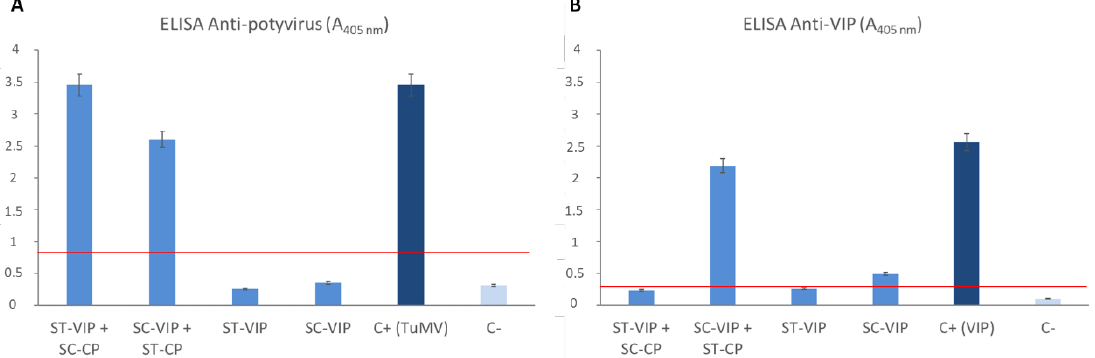
Figure 6. Observed absorbance values at 40 min from ELISAs carried out using anti-potyvirus or anti-VIP as primary antibody with the crude extracts of the different constructs of TuMV VLPs-VIP. The red bar indicates the threshold to consider a positive result (three times the value of the negative control). The error bars show the 95% confidence interval for the absorbance values. ST: SpyTag; SC: SpyCatcher; CP: TuMV capsid protein; VIP: vasoactive intestinal peptide; C+: positive control; C-: negative control.